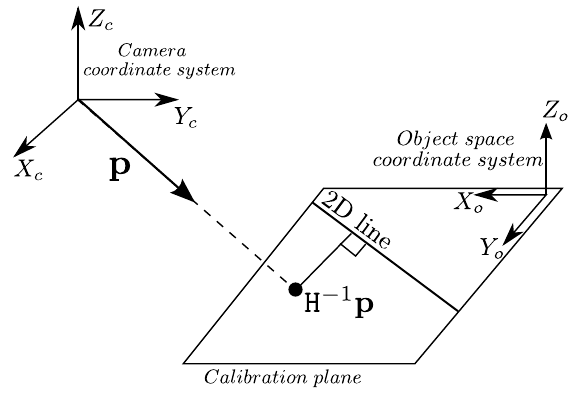
Figure 4: The geometric constraint used in this proposed calibra- tion algorithm. The constraint is based on the coincident relation between the back-projected image point and line in object space i.e., line on calibration